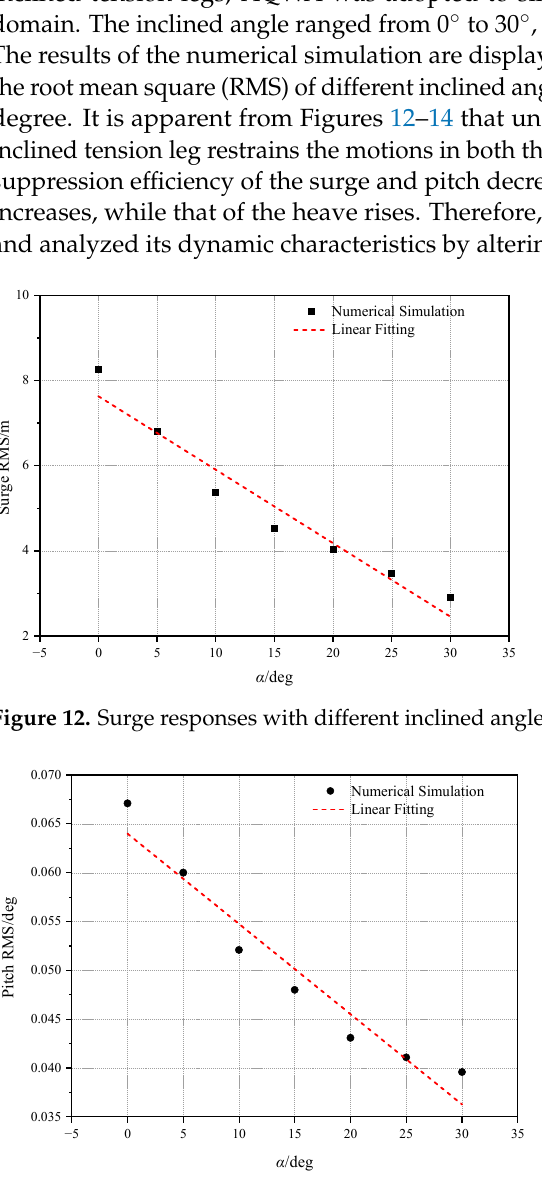
12 of 21 Figure 11. Pitch response spectrum. Figures 8 and 9 represent the time series of surge and pitch motion. The surge and pitch are oscillatory motions under the wave load, and their values significantly increase with increasing wave load. The time series obtained by AQWA and numerical simulation share similar changing trend. Figure 10 shows that the first spectrum peak of the model ’ s surge spectrum is near the platform ’ s natural frequency, and the peak value decreases with increasing sea state. Notably, the second peak value is near the wave spectrum peak frequency and increases